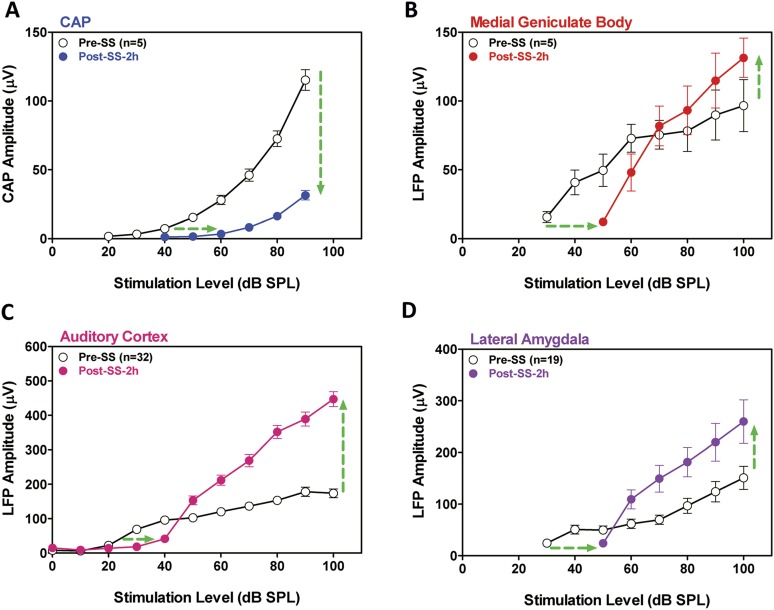
SS depresses cochlear potentials but enhances central auditory evoked responses.Effects of 300 mg/kg SS on peripheral and central electrophysiological measures. (A) Mean (+SEM, n = 5) compound action potential (CAP) input/output function (average of 6, 8, 12, 16, 20, 24, 30, and 40 kHz; 10-ms tone burst) recorded from the round window pre- and 2 hr post-SS. Note, 20 dB threshold shift of the function to the right at low intensities (horizontal arrow) and large reduction in CAP amplitude at high intensities (down arrow). (B, C, D) Local field potential input/output functions (50-ms noise bursts) from medial geniculate body, auditory cortex, and lateral amygdala (AMY), respectively, before and 2 hr post-SS. Note, 20 dB threshold shift of the functions to the right at low intensities (horizontal arrows) and large increase in response amplitude (up arrow) at suprathreshold levels (>60 dB SPL).